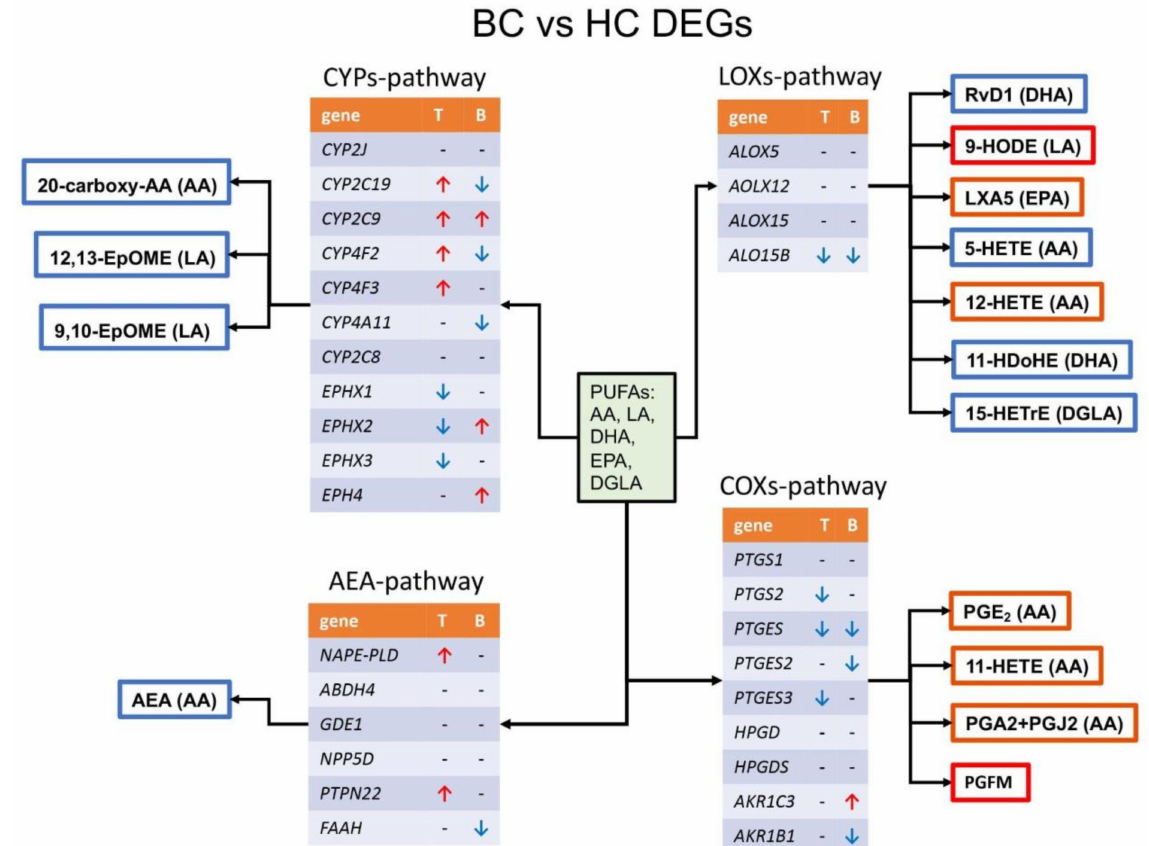
Figure 3. Schema of DEGs in tissue (T) and blood (B) BC patient transcriptomics datasets. Iden- tified DEGs are marked with a red arrow for induced genes in BC and a blue arrow for